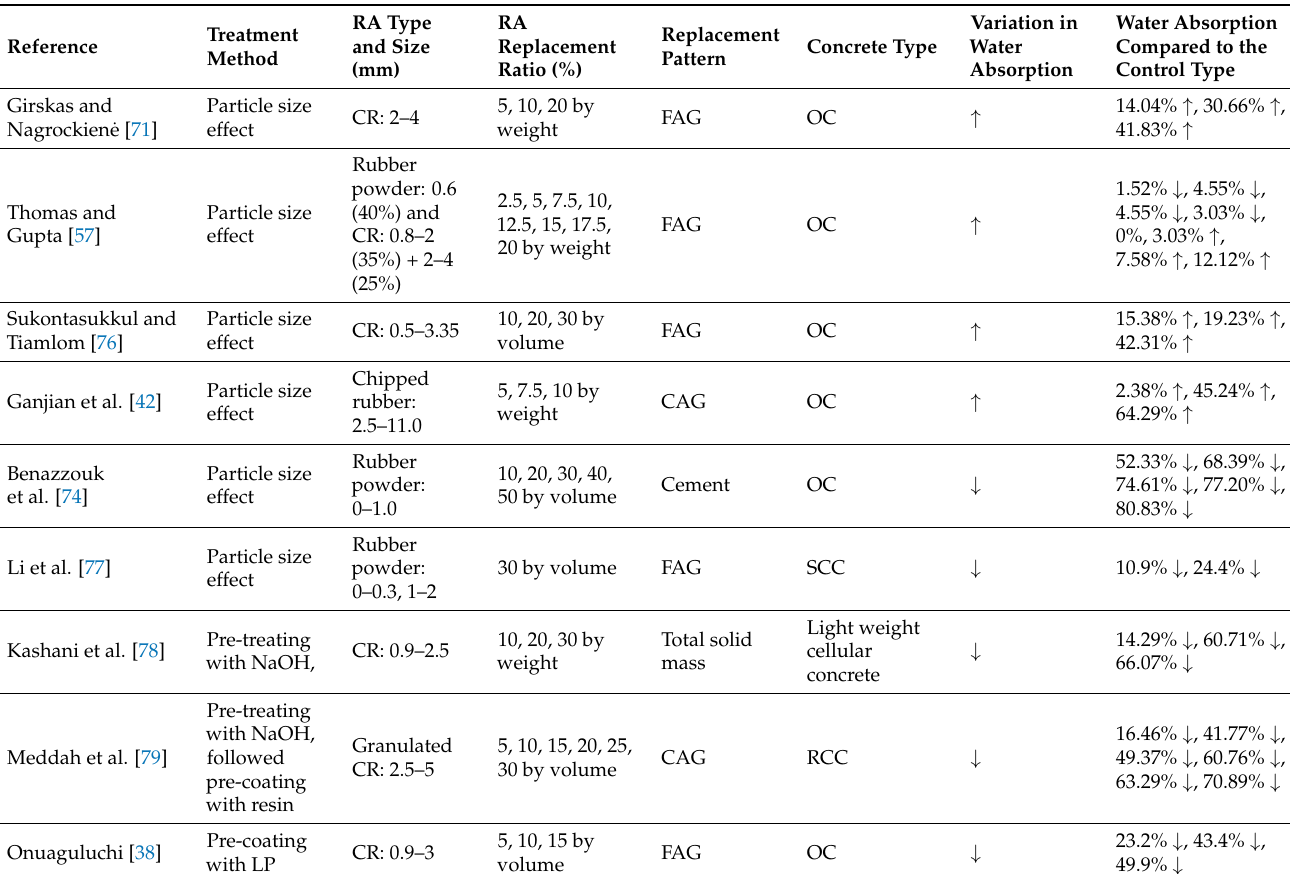
Figure 3. SEM images of fracture surface of cement test specimen. ( a ) Rubber particle; ( b ) Cement paste [27].